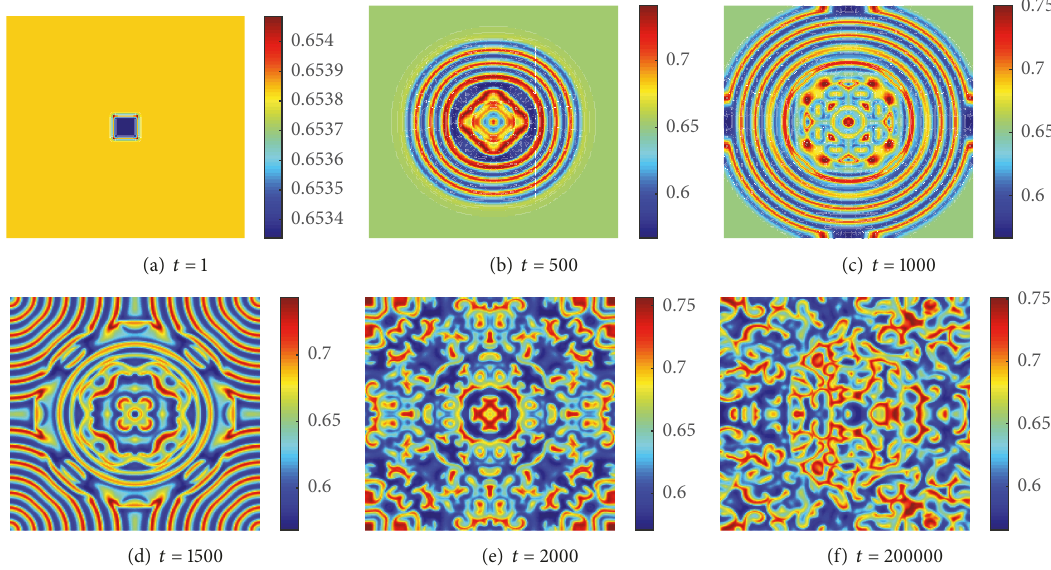
Figure 9: Pattern formation resulting from spatially symmetry breaking on period-31 orbit and starting with deterministic initial condition. 𝑎 = 1.63, 𝑏 = 0.1, 𝑐 = 0.32, 𝑑 = 0.22, 𝐷 𝐷 𝜏 = 5.525, 𝛿 = 10, and 𝑛 = 1 = 0.6, 2 = 1.2,